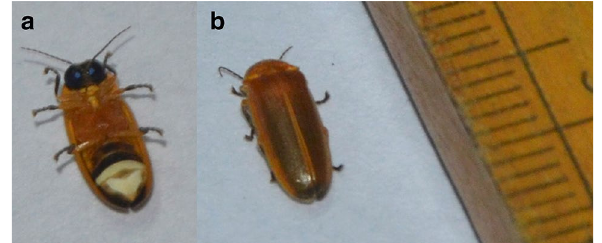
Figure 1. A specimen of male adult firefly S. substriata . ( a ) Ventral side. ( b ) Dorsal side. Average lengths and weights of the collected specimens are 9 mm and 10 mg, respectively. In the campus of Gauhati University, this species is mostly found flashing from trees on the banks of two large ponds lying side by